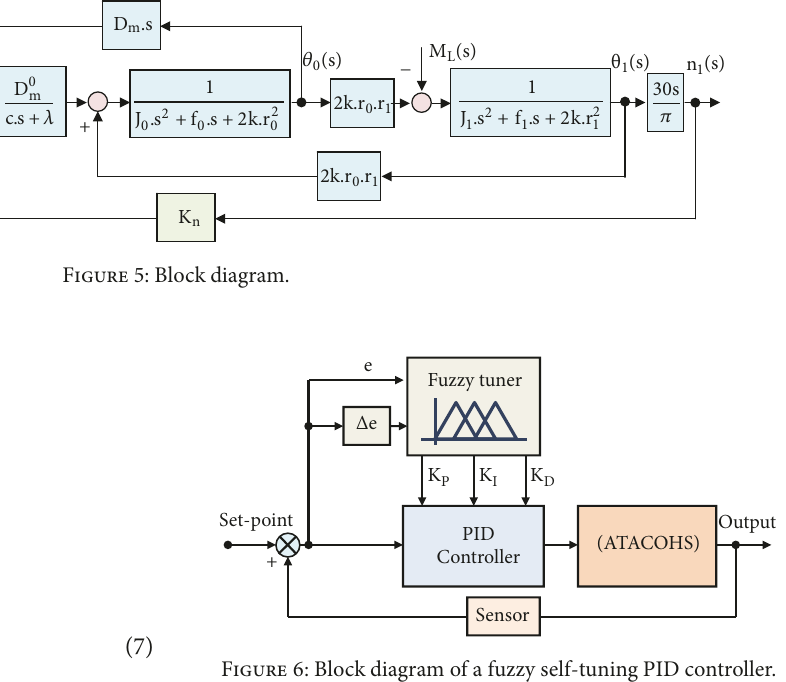
Figure 6: Block diagram of a fuzzy self-tuning PID